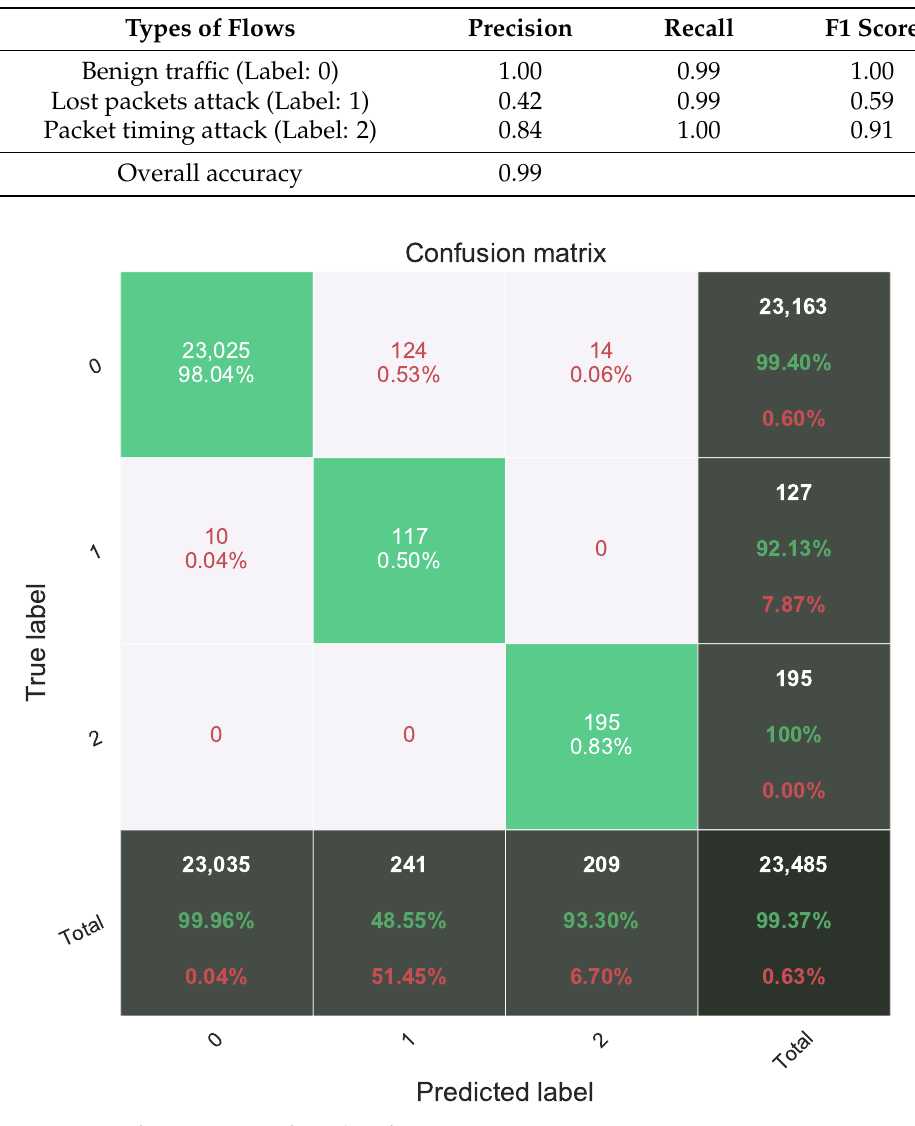
Table 8. Performance of custom MLP classifier in terms of precision, recall, F1 score, and overall accuracy metrics.